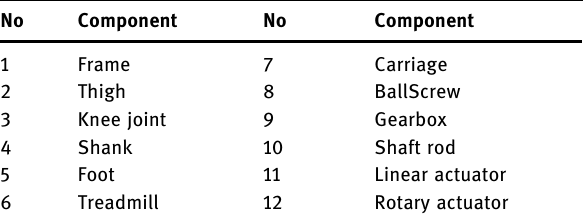
Table 1: The components of the whole